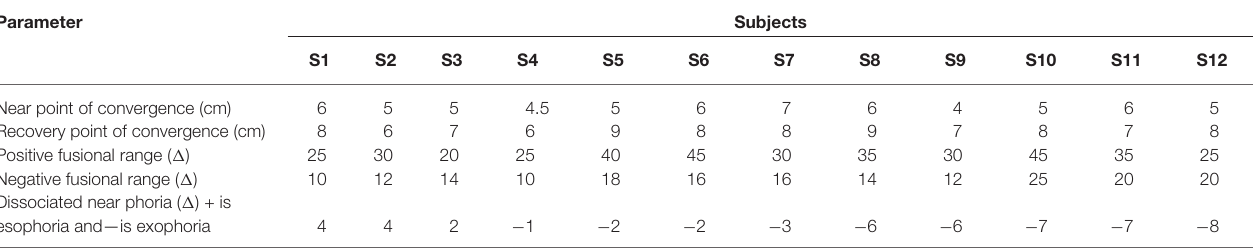
TABLE 2 | Clinical parameters from the BNC subjects for near point of convergence (NPC), recovery point of convergence (RPC), positive (base out) and negative (base in) fusional range, and dissociated near phoria. Parameter Subjects S1 S2 S3 S4 S5 Near point of convergence